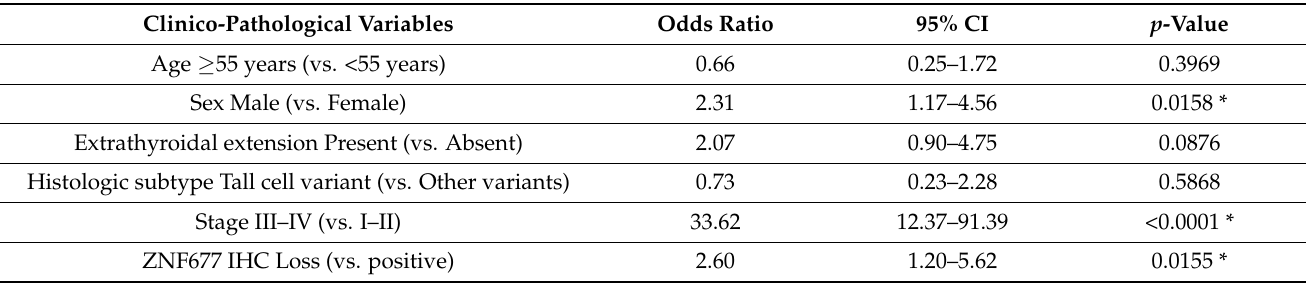
Table 3. Multivariate logistic regression analysis to assess the relationship between distant metastasis and clinico- pathological